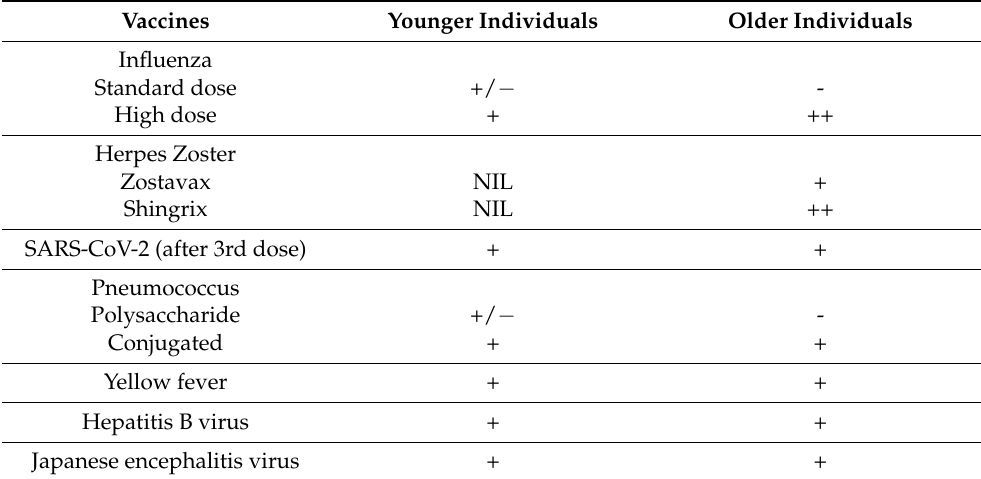
Table 1. Past and present vaccines for older subjects considering their clinical efficiency. Vaccines Younger Individuals Older Individuals Influenza Standard dose +/ −